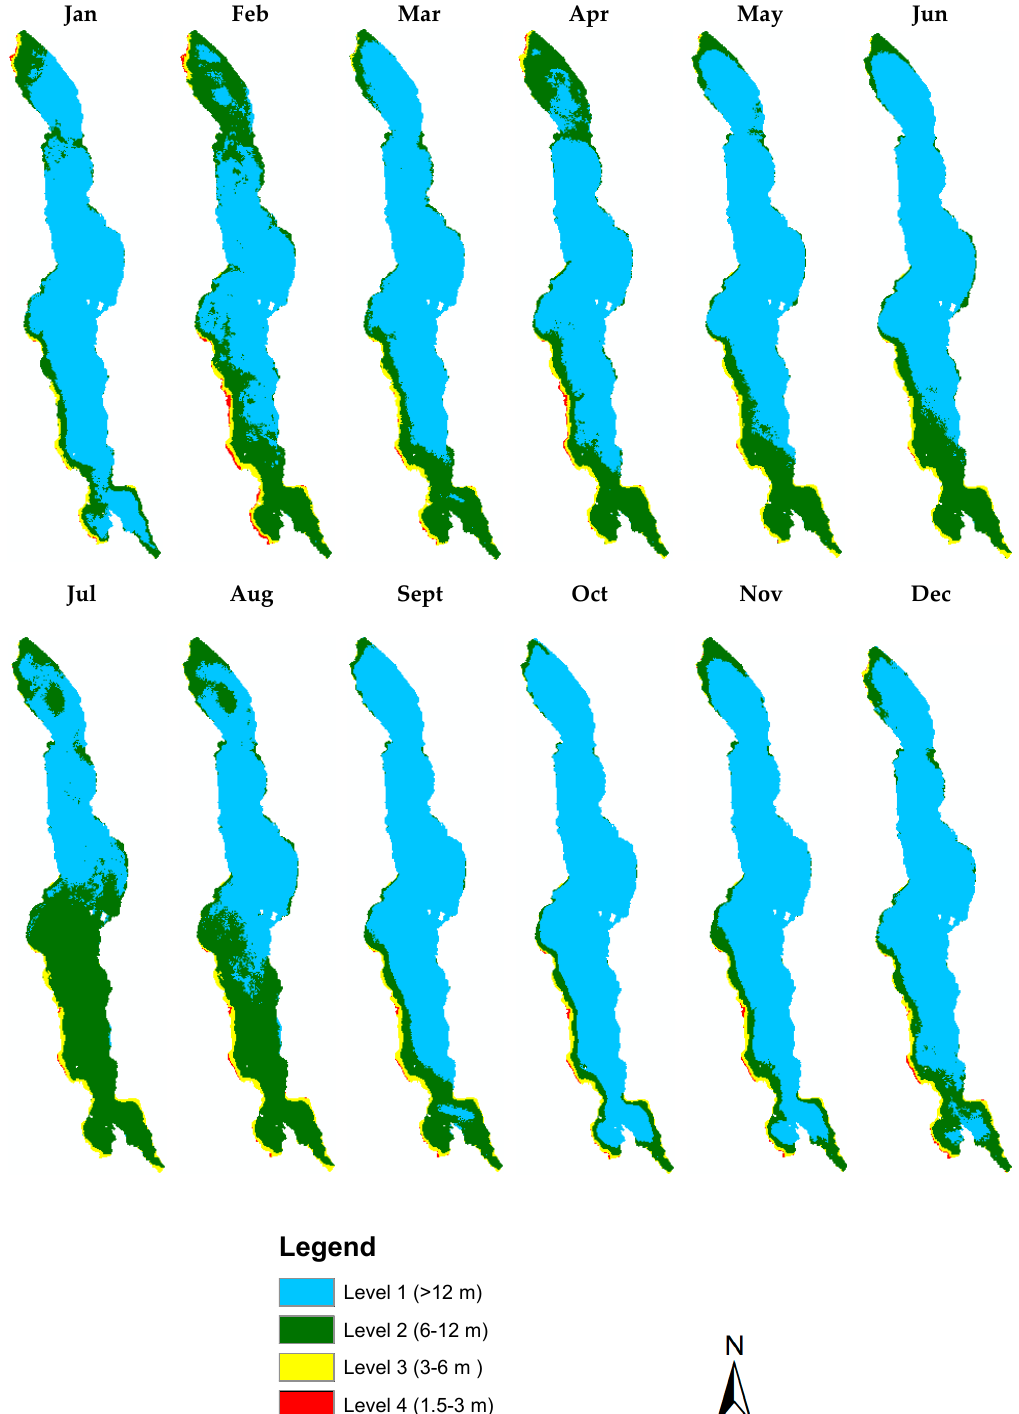
Figure 7. Monthly water transparency level maps in Lake Malawi. These maps were generated from monthly SD distribution maps (obtained from MERIS data using the Lee15 algorithm) based on the OECD classification system